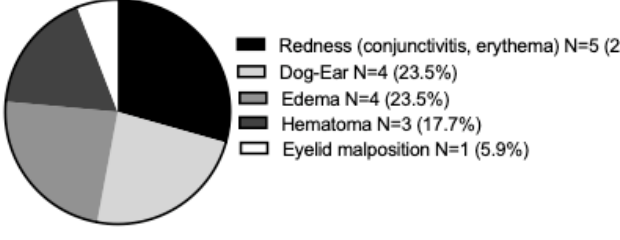
Figure 2. ( A ) Results of the patient`s satisfaction questionnaire (using a patient-reported outcome